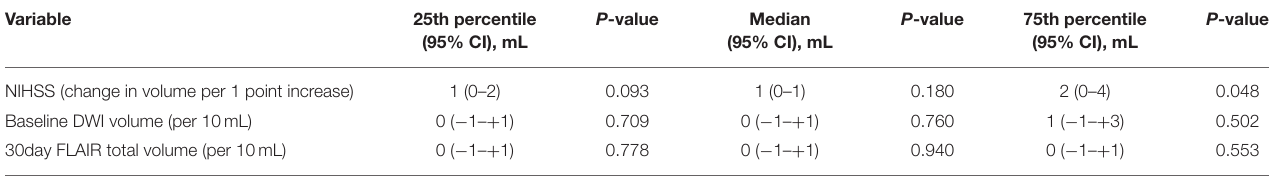
TABLE 2 | Brain volume change and stroke severity/size, adjusted for baseline brain volume (positive numbers indicate decrease in volume). Variable